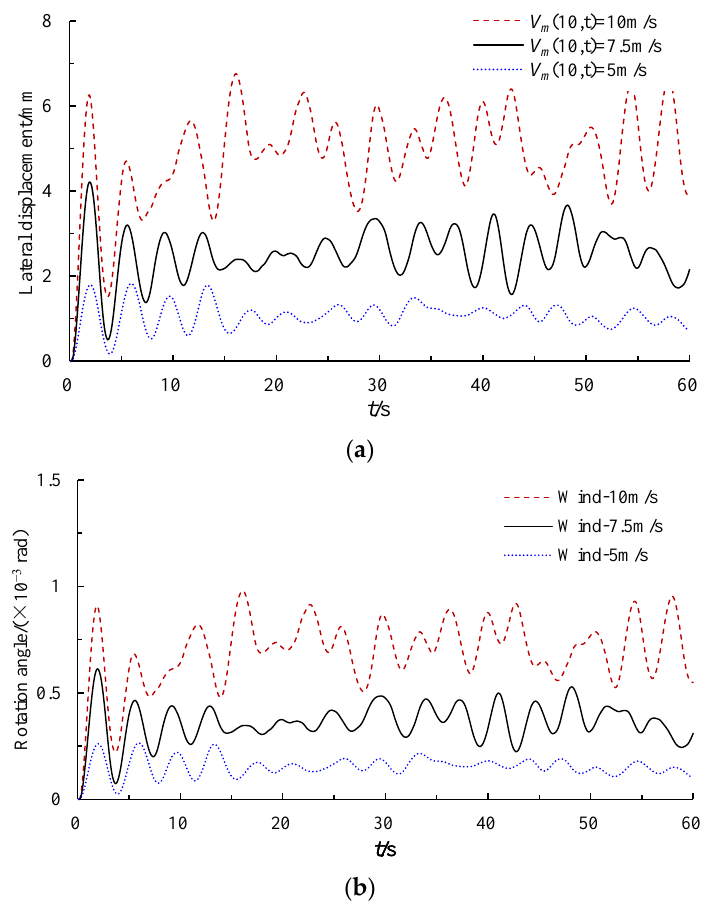
Figure 13. Dynamic response of the GBF under different wind loads: ( a ) lateral displacement; ( b ) rotation angle.